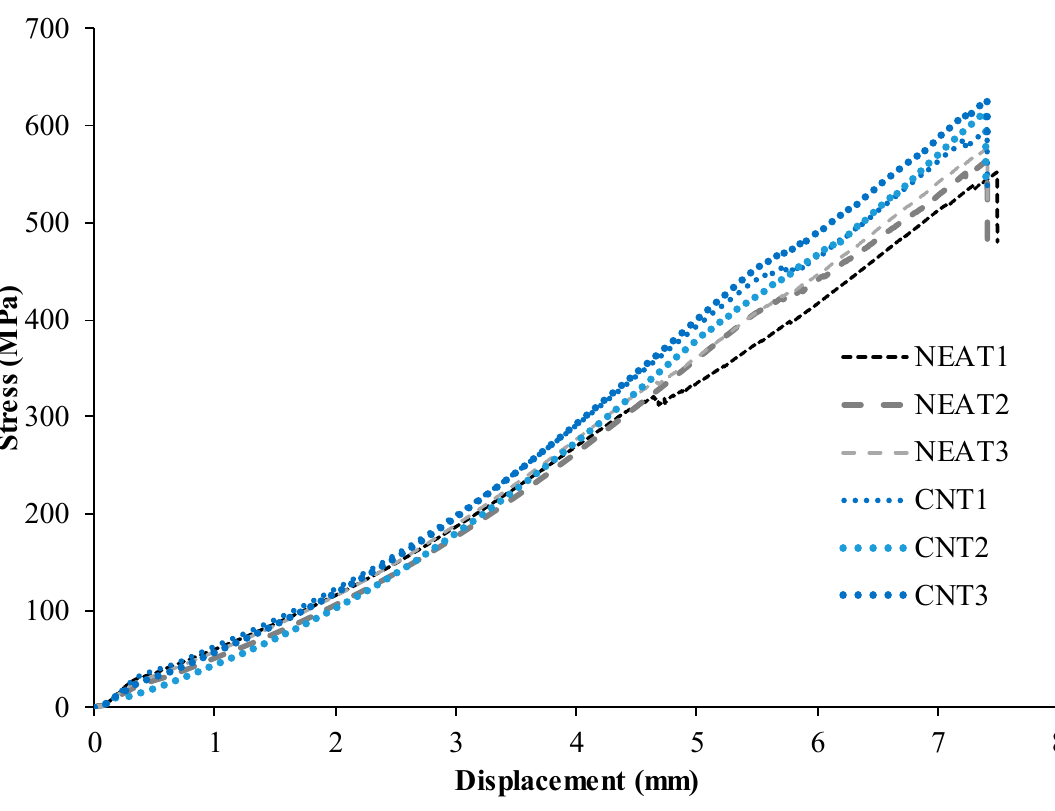
Figure 4. Tensile test results of the samples.